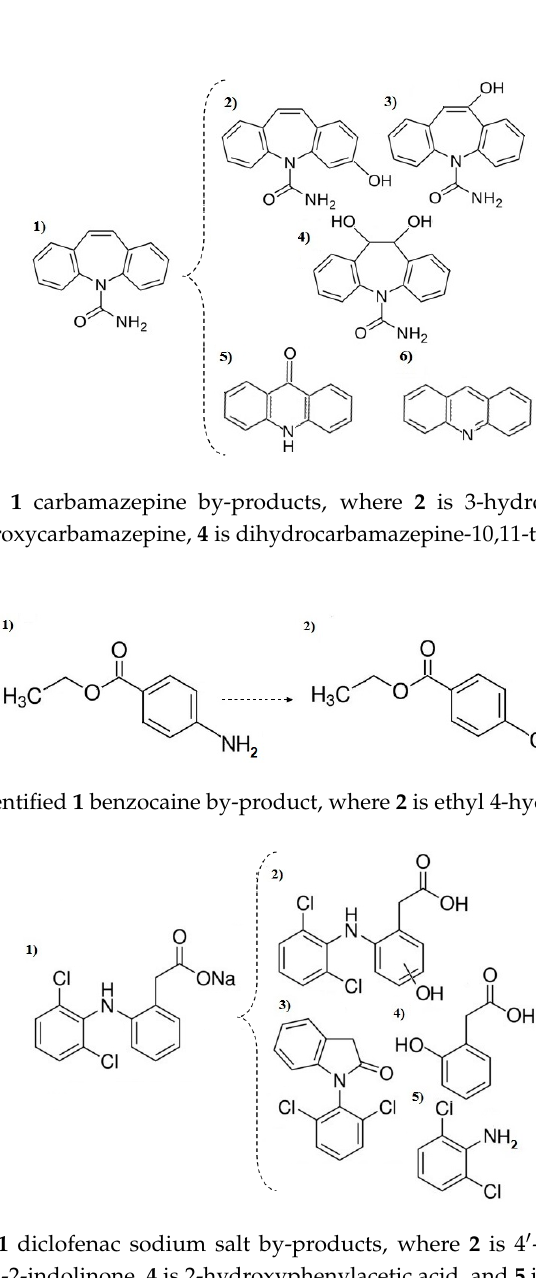
Figure 6. Identified 1 diclofenac sodium salt by-products, where 2 is 4 ′ -hydroxydiclofenac, 3 is 1-(2,6-dichlorophenyl)-2-indolinone, 4 is 2-hydroxyphenylacetic acid, and 5 is 2,6-dichloroaniline.